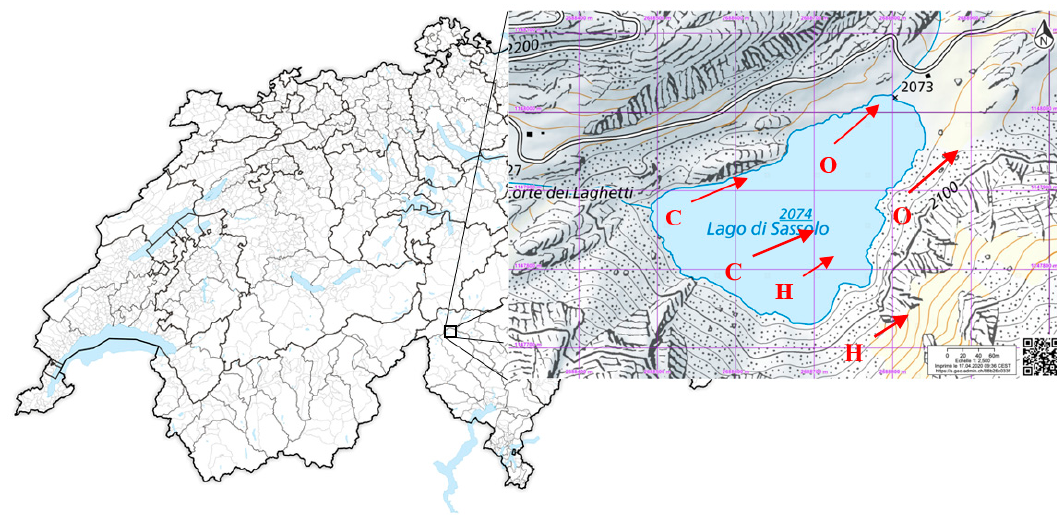
Figure 1. Location of Lake Sassolo and the sampling sites (C: cliff, H: main hole, and O: outlet).